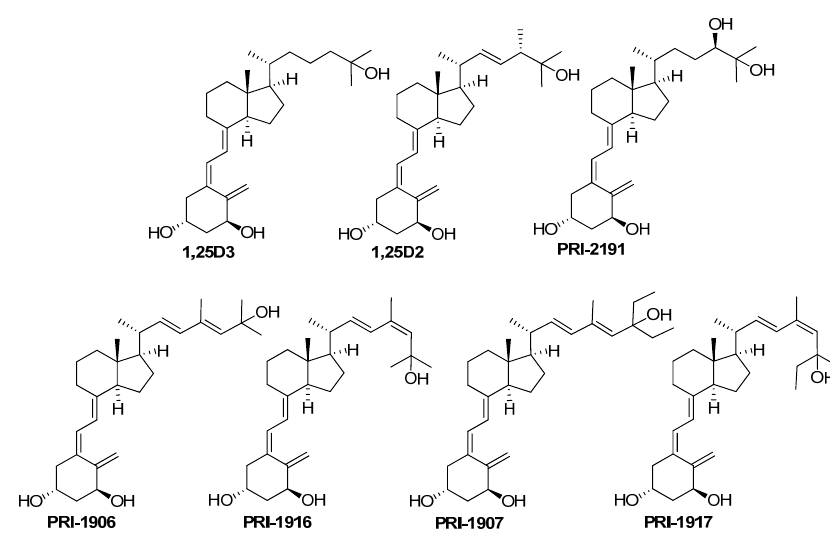
Figure 1. Structures of 1,25-dihydroxyvitamin D 3 (1,25D3), 1,25-dihydroxyvitamin D 2 (1,25D2), analogue of 1,25D3 (PRI-2191) and analogues of 1,25D2 (PRI-1906, PRI-1916, PRI-1907 and PRI-1917).